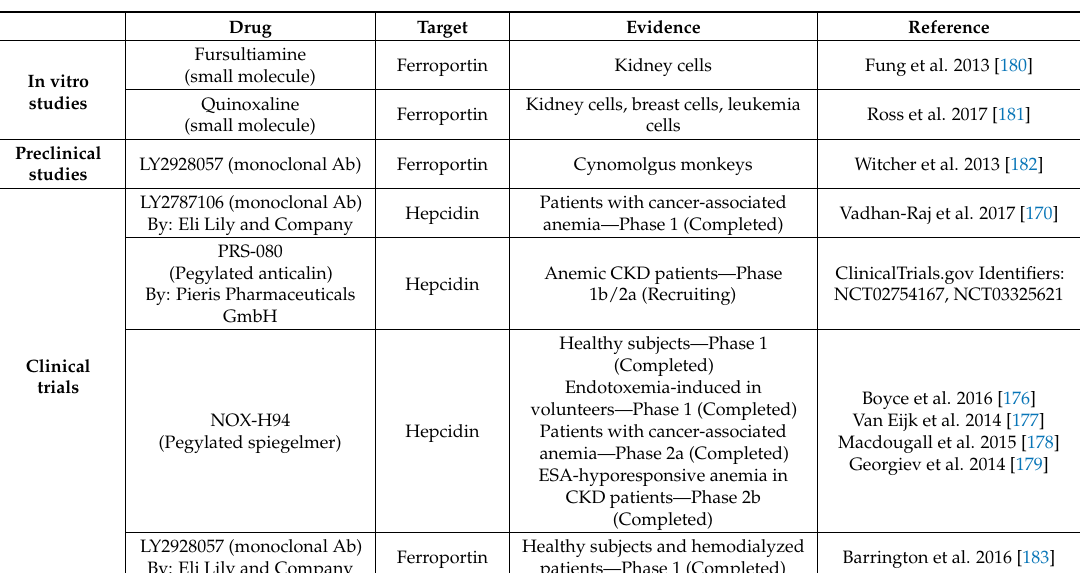
Table 5. Hepcidin